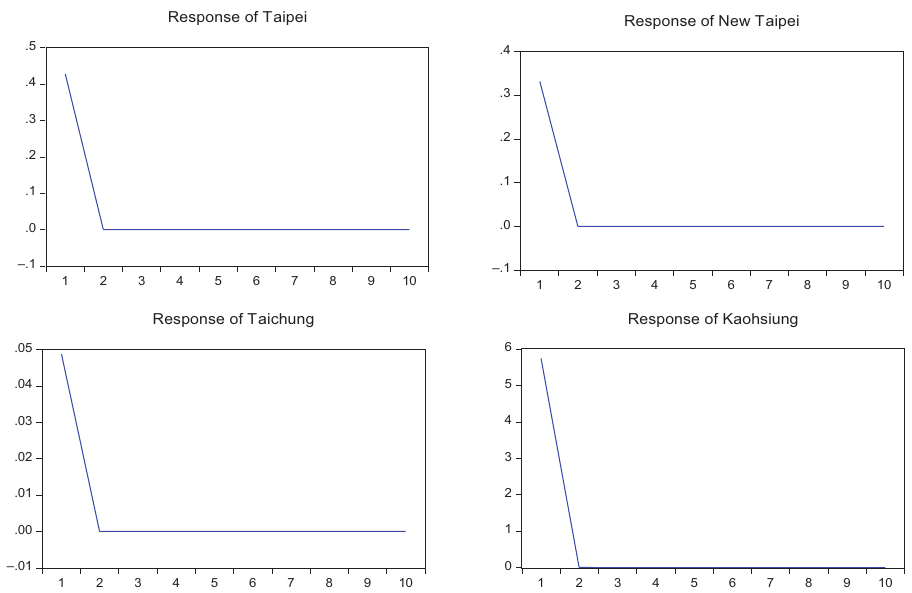
Figure 6. Response of housing market volatility on the shock from money